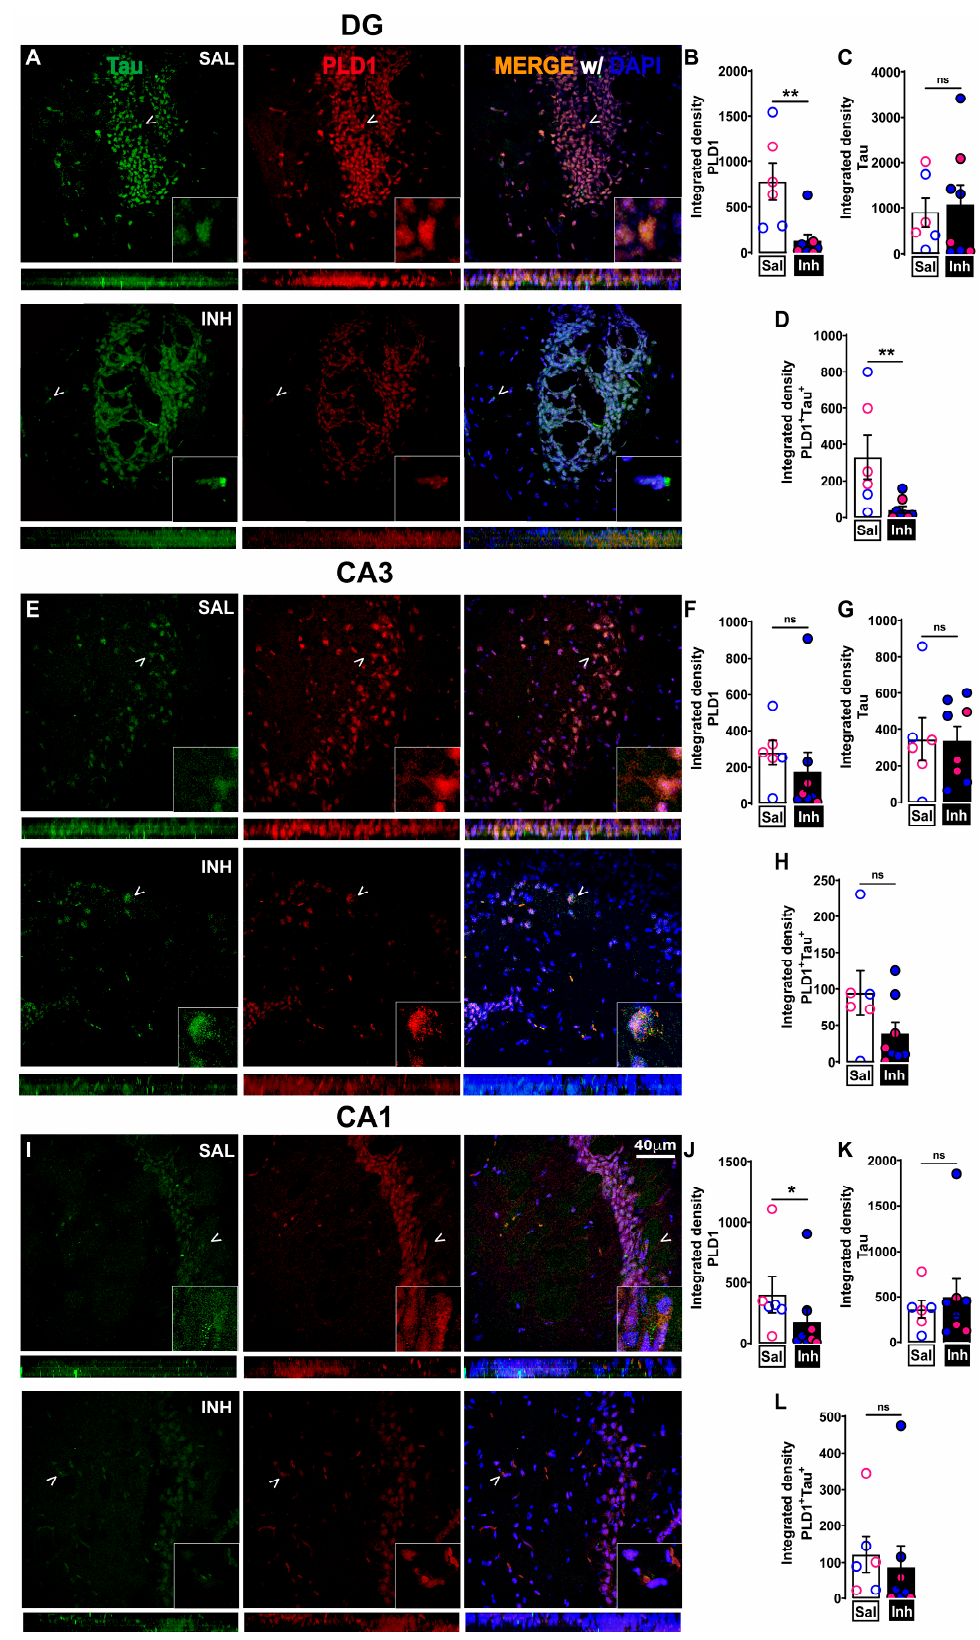
Figure 3. Repeated VU01 (1 mg/kg/2 days for a month) in 12-month-old 3xTg-AD mice attenuates PLD1-tau expression differentially in hippocampal subregions. ( A ) Double immunofluorescence